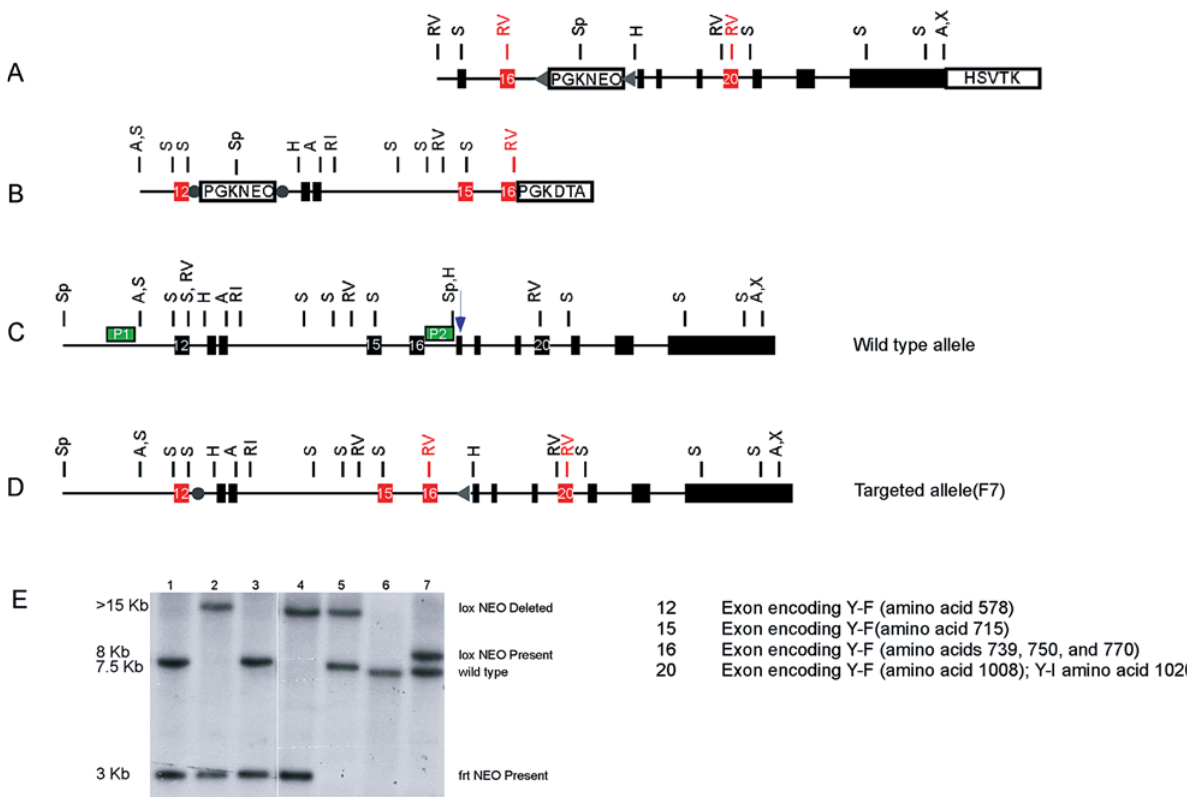
Figure 2. Targeting Strategy and Southern Blot (A) Targeting vector used to create F5 mutant allele. Two exons contain all five mutated tyrosines. (B) Targeting vector containing mutations in 5 9 exons used to generate the F7 mutant allele. (C) Wild-type allele. (D) Targeted allele with PGK–neo removal. Restriction enzyme abbreviations: Sp, Spe I; A, Asp 718; S, Sac I; RV, Eco RV; H, Hind III; X, Xho I; and RI, Eco RI. Green boxes indicate probes used in Southern blotting for F7-targeted ES cells. The blue arrow indicates the exon where point